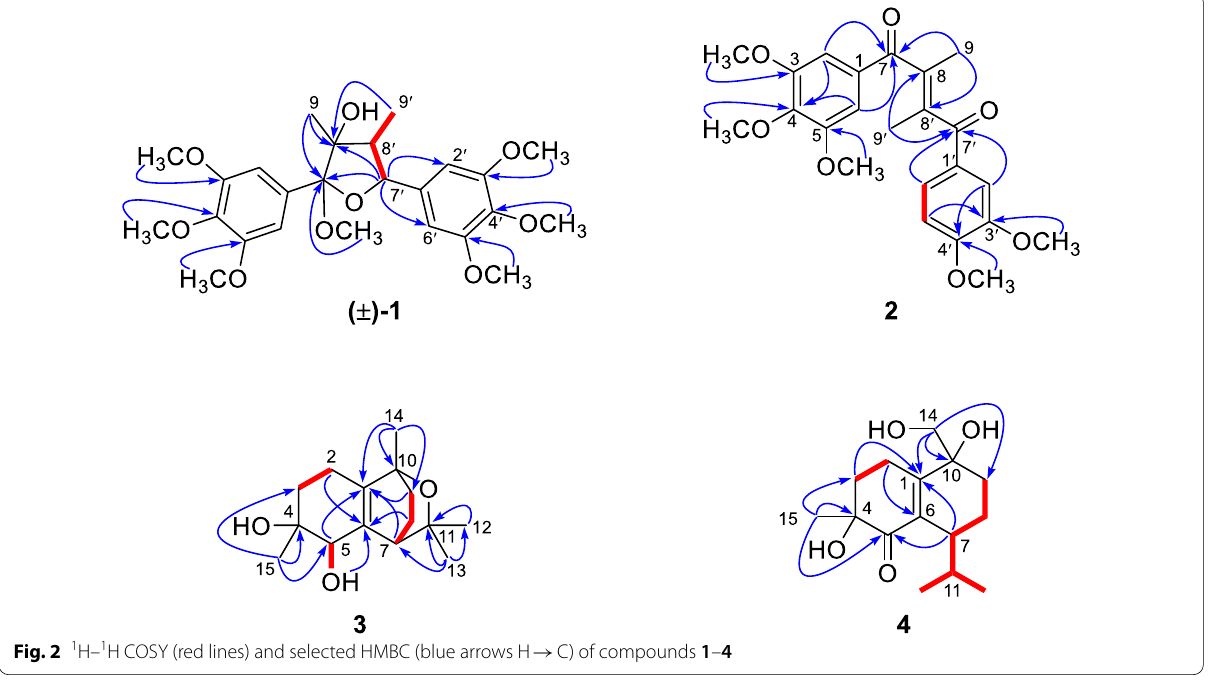
Fig. 2 1 H– 1 H COSY (red lines) and selected HMBC (blue arrows H